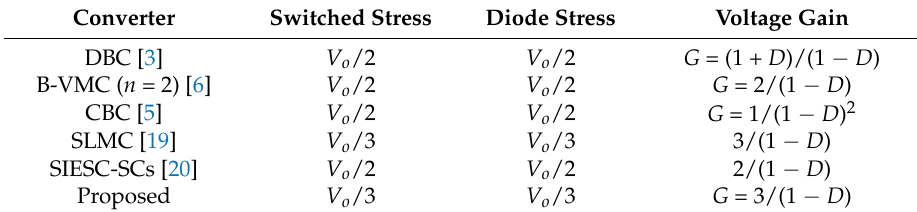
Table 4. Comparison voltage stress and gain of topologies.